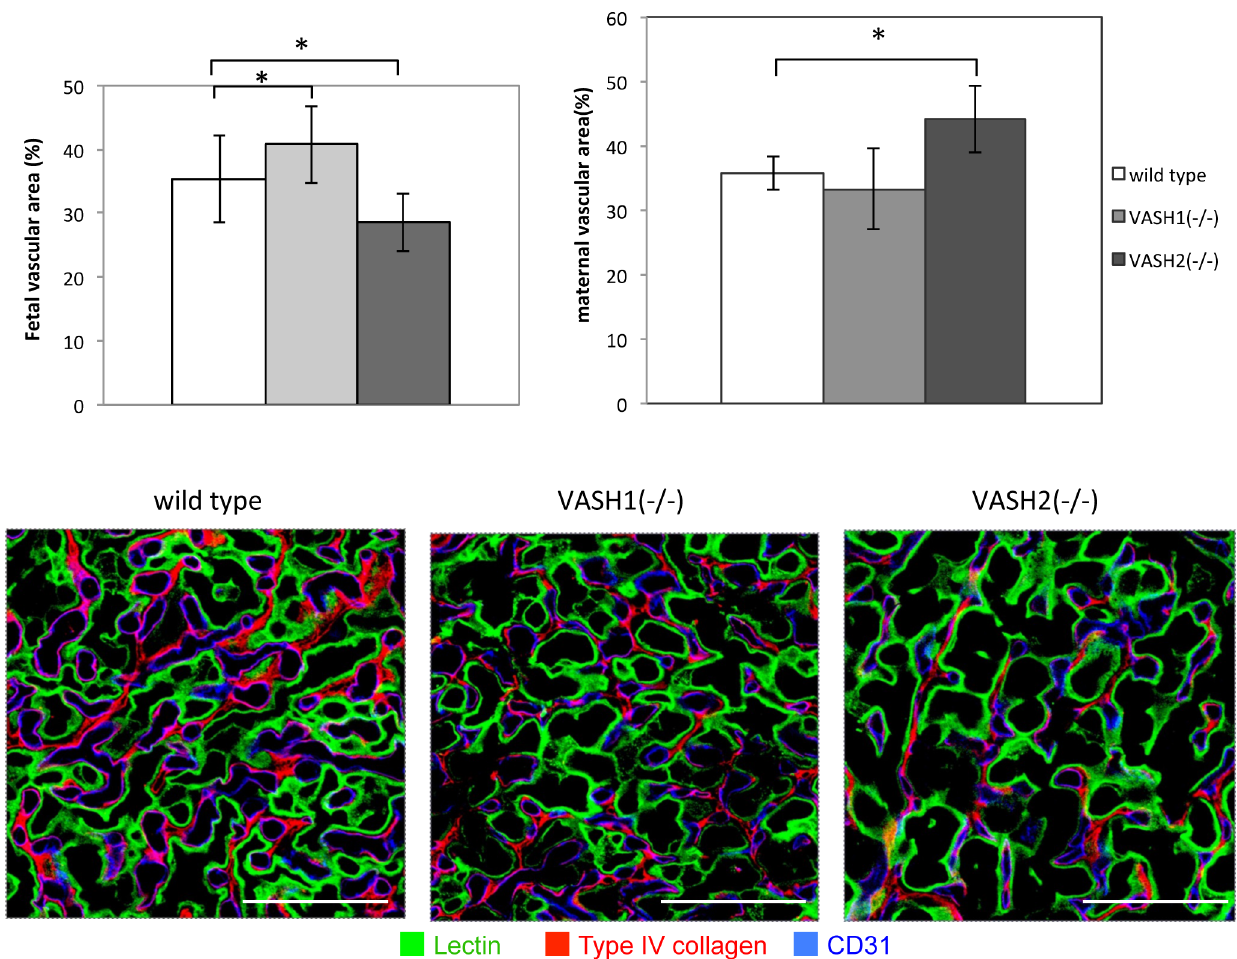
Figure 3. Vascularization of placenta in WT, Vash1 ( 2 / 2 ) , and Vash2 ( 2 / 2 ) mice. Upper panels show vascular morphogenesis. The triple staining with tomato lectin (green), anti-CD31 (blue), and anti-type IV collagen (red) was performed as described in Materials and Methods. Tomato lectin identified the maternal blood vessels; and CD31-positive structures, the fetal blood vessels. The presence of type IV collagen indicated the basement membrane. Bar=50 m m. Lower graph on the left show the fetal vascular area, and that on the right shows the maternal vascular area determined for WT (N=5), Vash1 ( 2 / 2 ) (N=3), and Vash2 ( 2 / 2 ) (N=3) placentas. Ten 400 6 fields per placenta were used for quantification. *P , 0.01.